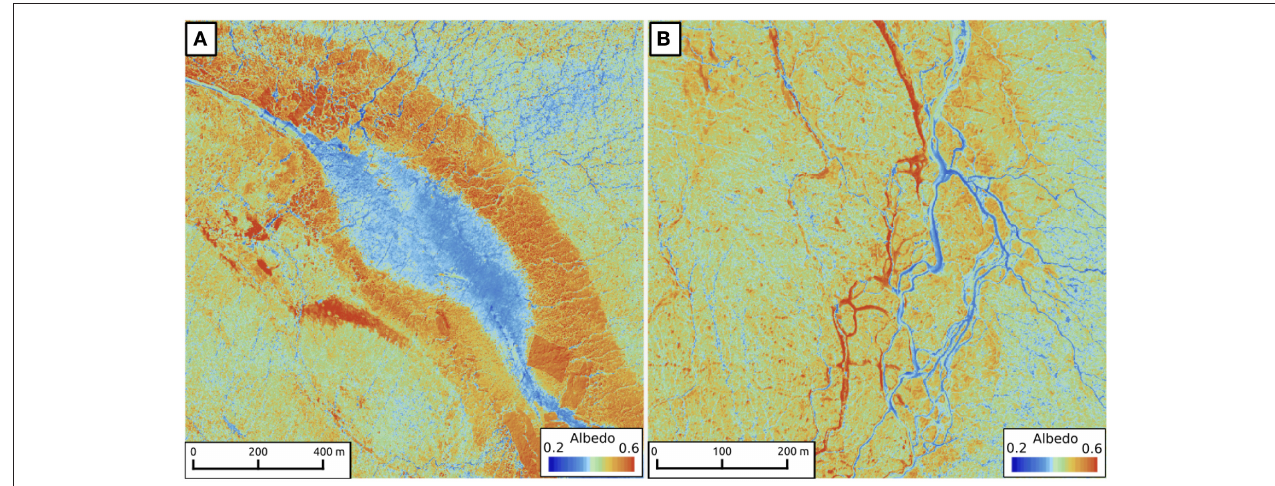
FIGURE 11 | (A) Supraglacial lake with lake ice grounded on the shore. (B) Braided supraglacial